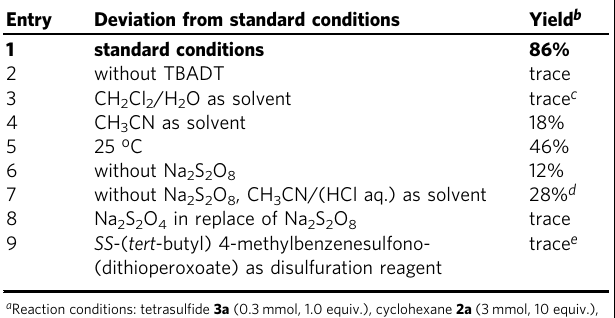
Table 1 Optimization of the reaction conditions a